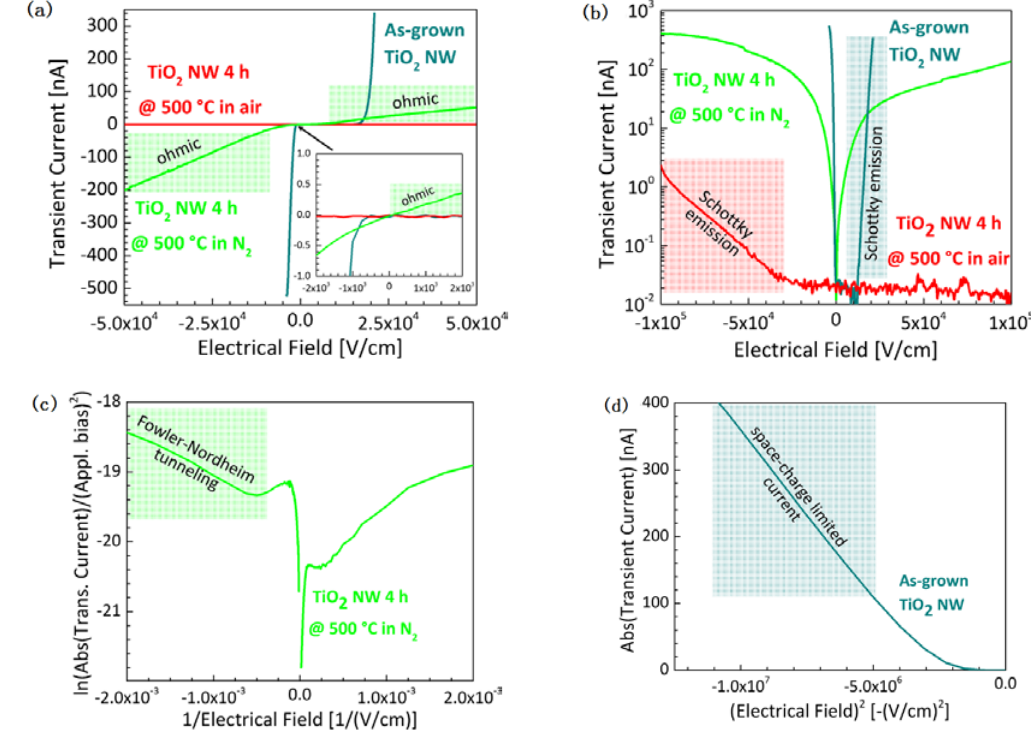
Figure 6. Transient current characteristics through as-grown NWs, NWs annealed in air, or in N 2 that is measured between a PtIr top and an FTO bottom electrode. The different plots emphasize several conduction-limiting mechanisms: ( a ) Linear plot showing ohmic behavior and the inset is a zoom in on the point of origin, ( b ) Schottky plot, ( c ) Fowler–Nordheim plot and ( d ) space–charge-limited current plot [39].